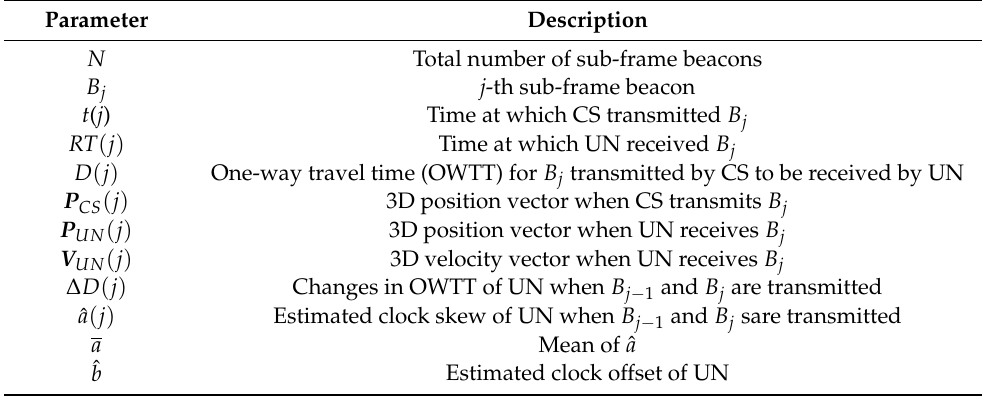
Table 1 defines the parameters related to the PTA-Sync results. Table 1. Parameter description of PTA-Sync.